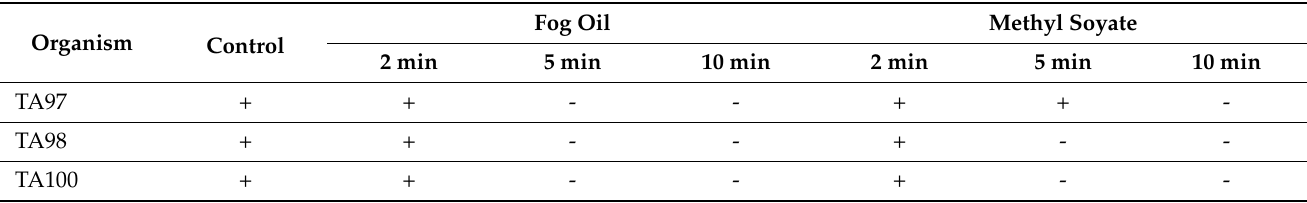
Table 5. Exposure results of plates covered with stationery paper.